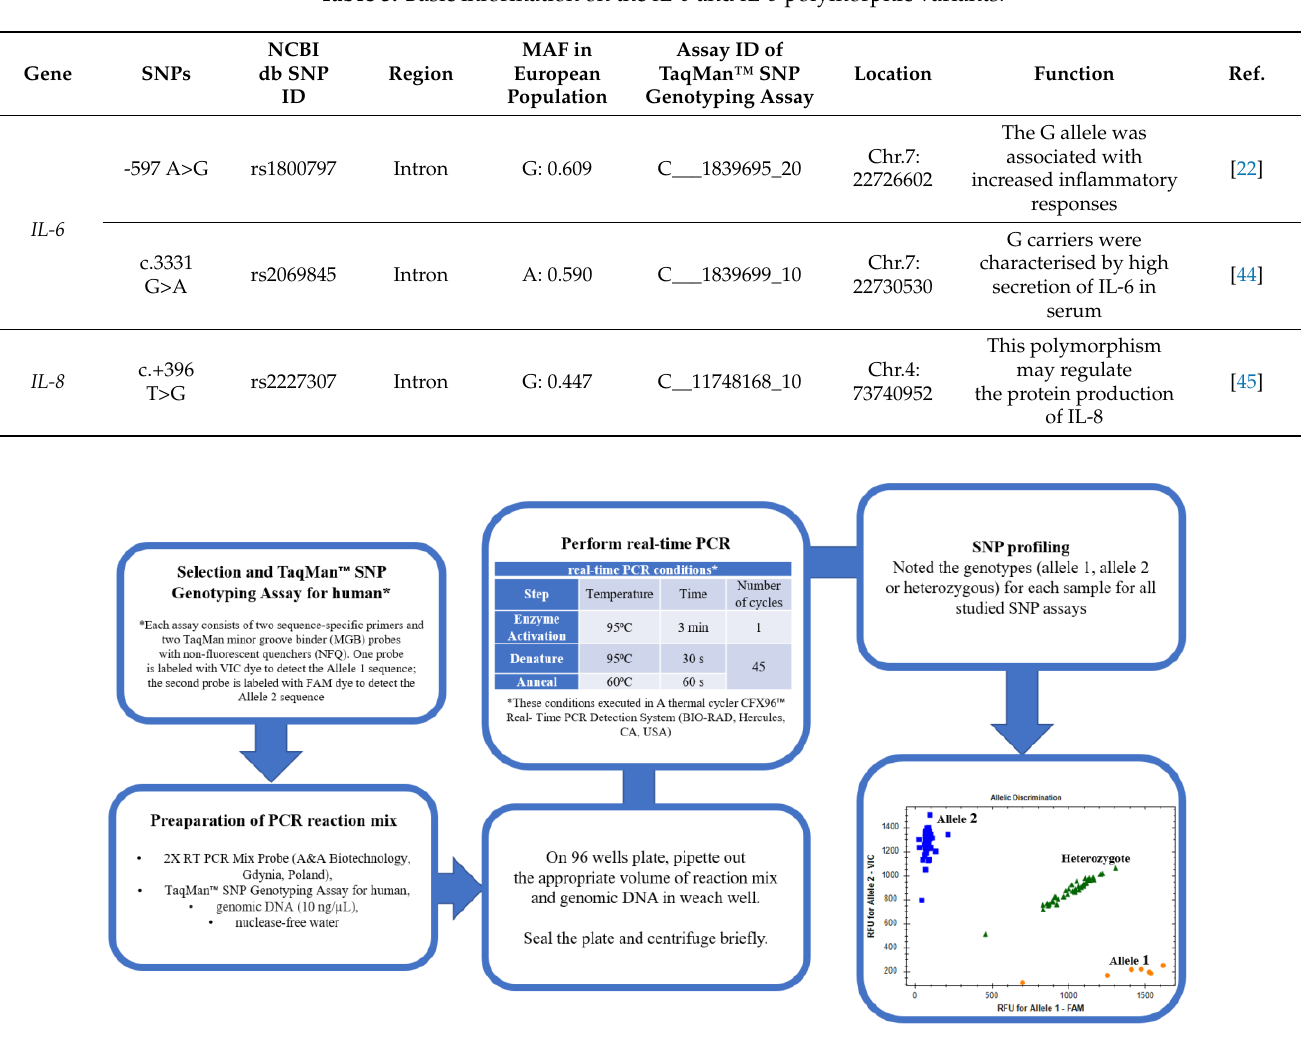
Table 5. Basic information on the IL-6 and IL-8 polymorphic variants.